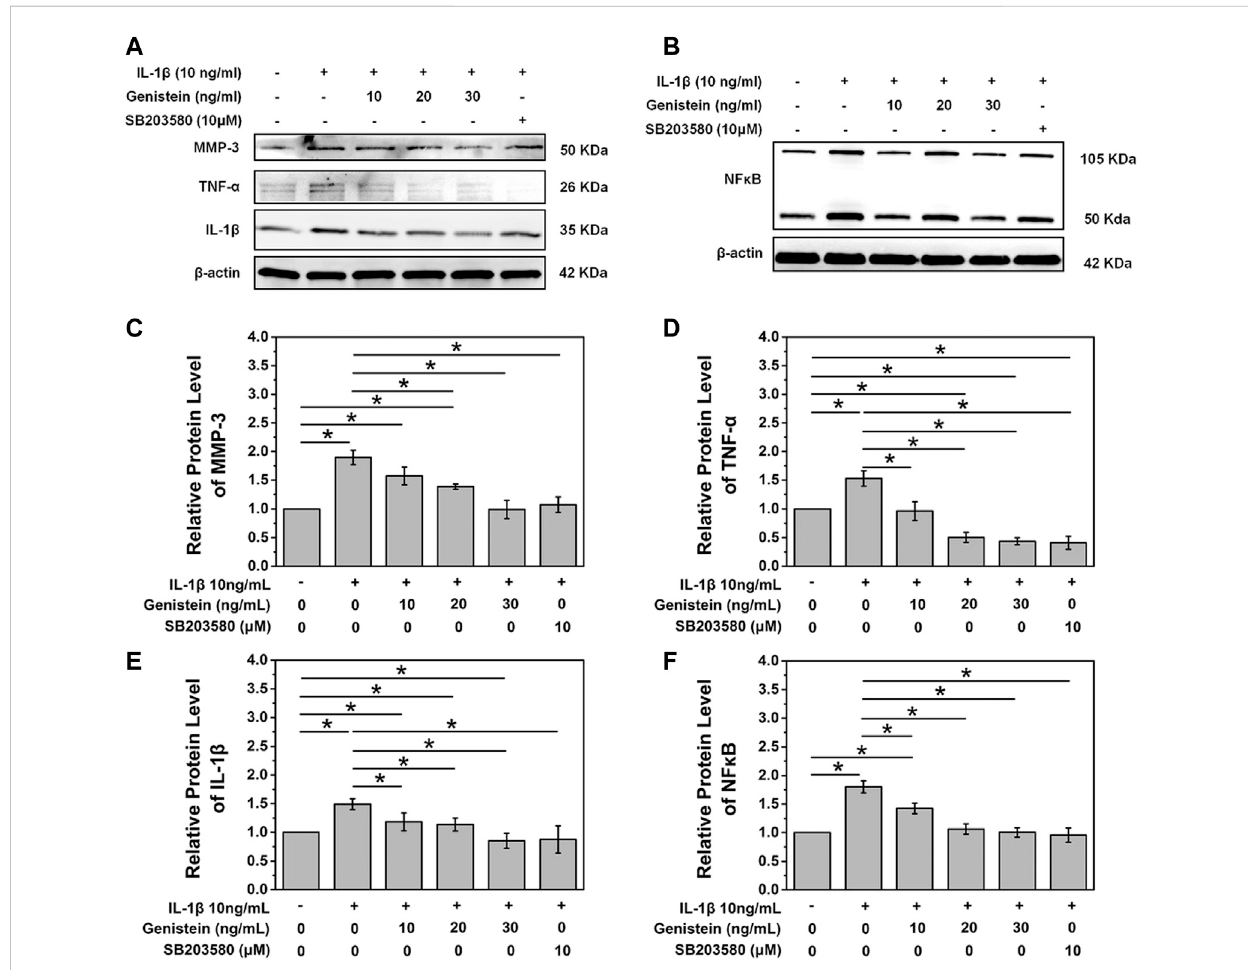
FIGURE 4 A comparison of the protein expression of MMP-3, TNF- α , and IL-1 β in each group (A) A comparison of the protein expression of NF- κ B in each group (B) QuantitativeanalysisoftheproteinlevelsofMMP-3 (C) ,TNF- α (D) ,IL-1 β (E) ,andNF- κ B (F) , “ * ” p < 0.05.SB203580,aspeci fi cp38MAPKinhibitor. Reproduced with permission from a previous publication (Ge et al.,